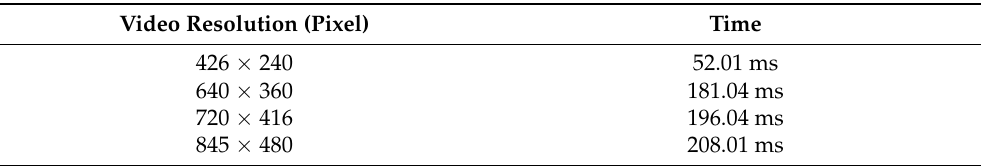
Table 7. Time consumption of STPM_SAHI for real-time detection of each frame of forest fire videos with different resolutions (video resolution refers to the number of pixels contained in a video in a certain area).